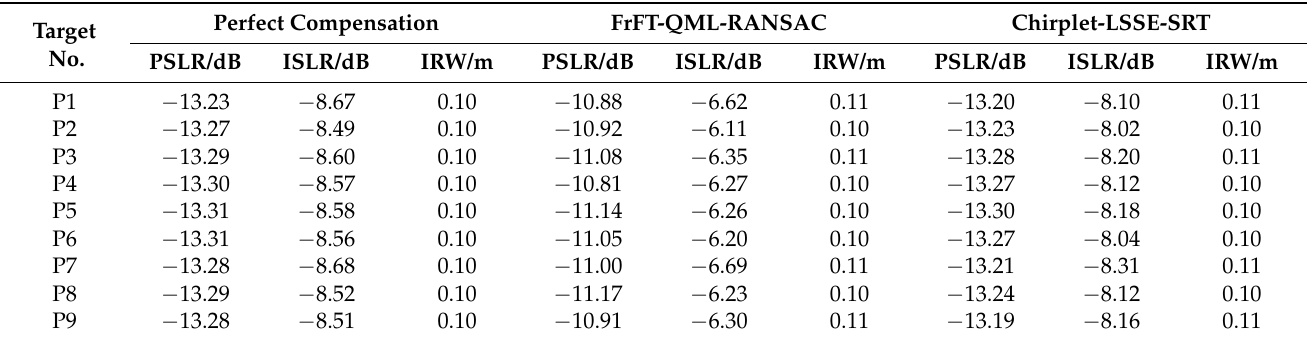
Table 4. Measured imaging quality metrics of azimuth